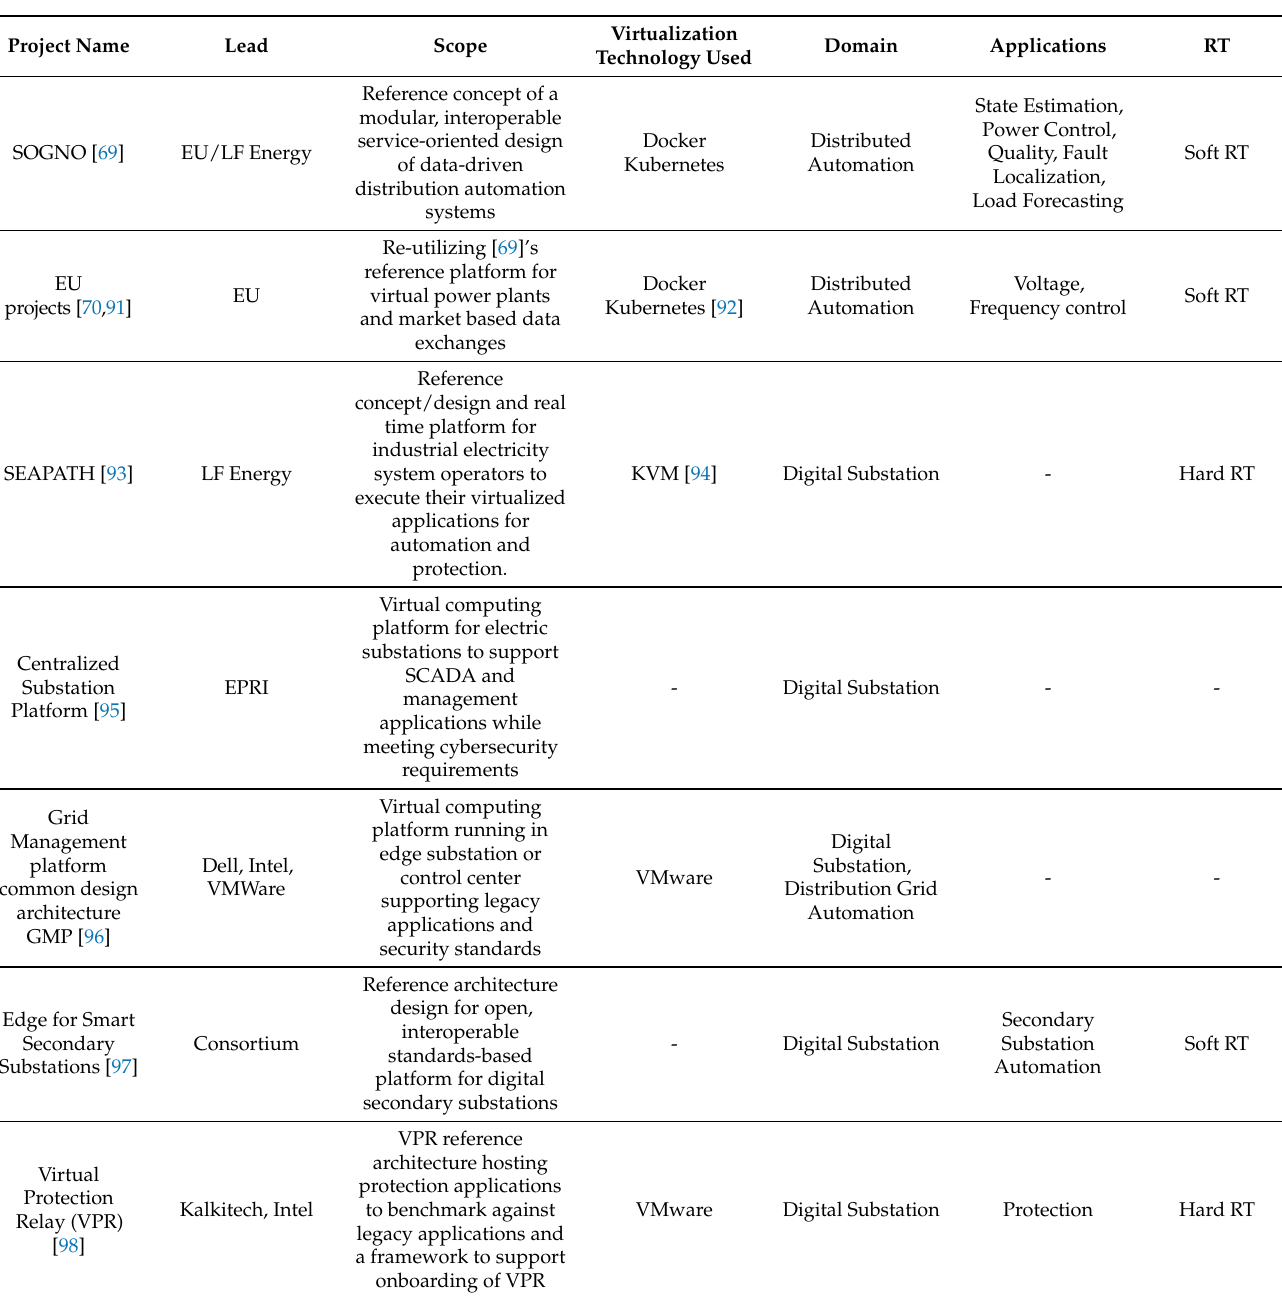
Table 4. Industrial proofs of concepts for virtualized PAC